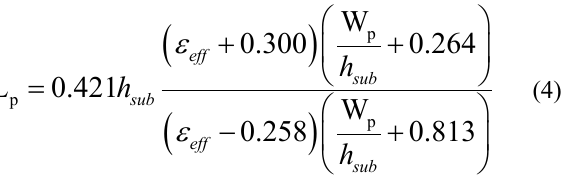
FIGURE 1. The proposed CPW-fed UWB antenna. TABLE I. Values of Design Parameters